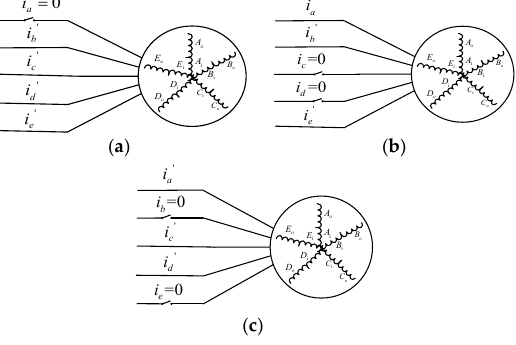
Figure 4. Three fault types when the motor operates in series drive mode. ( a ) Single ‐ phase open ‐ circuit fault; ( b ) adjacent double ‐ phase fault; ( c ) nonadjacent double ‐ phase fault.